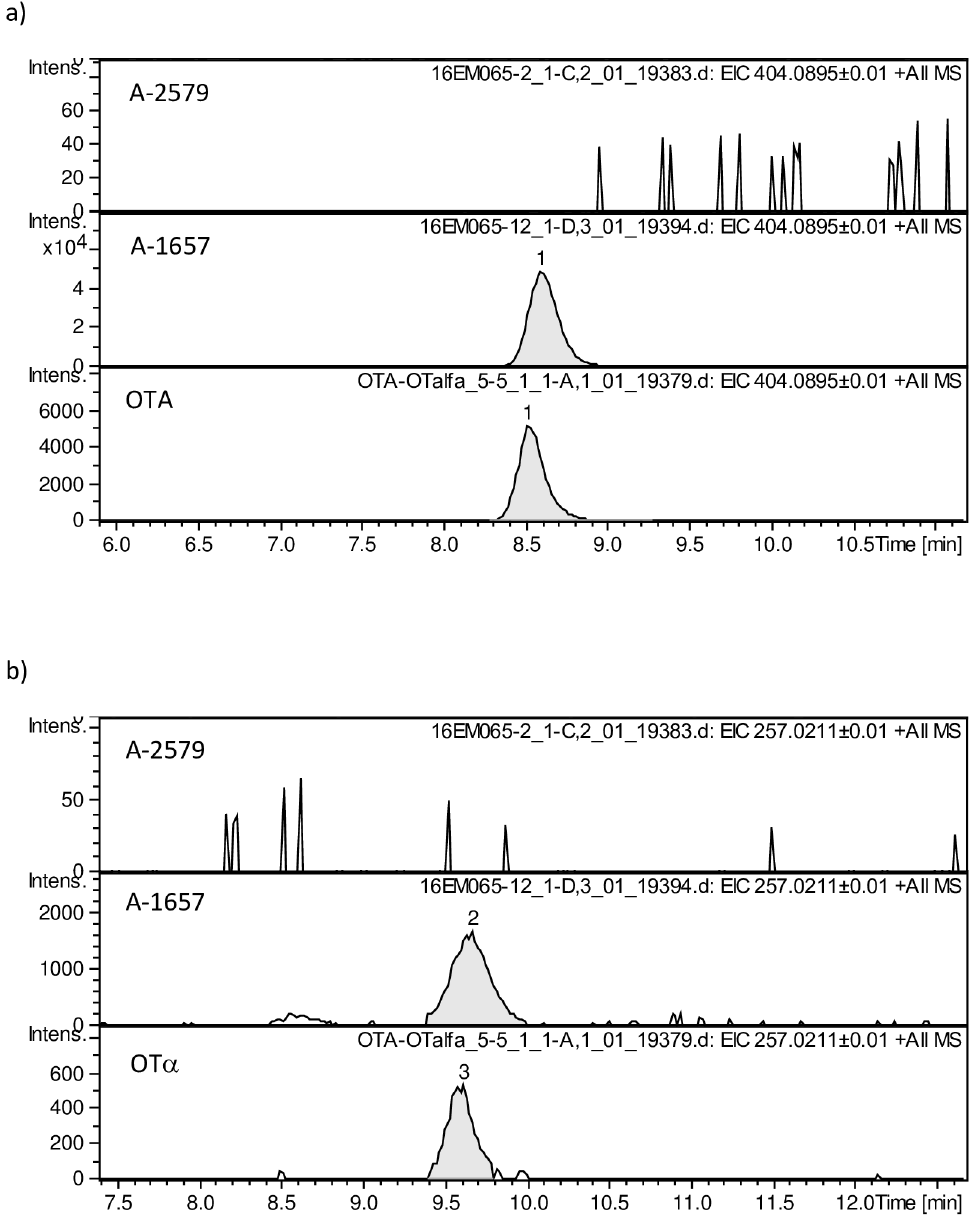
Fig 3. Selected extracted ion chromatograms of fungal extractsand (a) OTA and (b) OT α standards analysed using HPLC-MS and an OTA/OT α -producing strain ( A . carbonarius A-1657) and a non-OTA/ OT α -producing strain ( A . carbonarius A-2579), after incubation at 15˚C for 30 days on Czapek Yeast extractAgar.